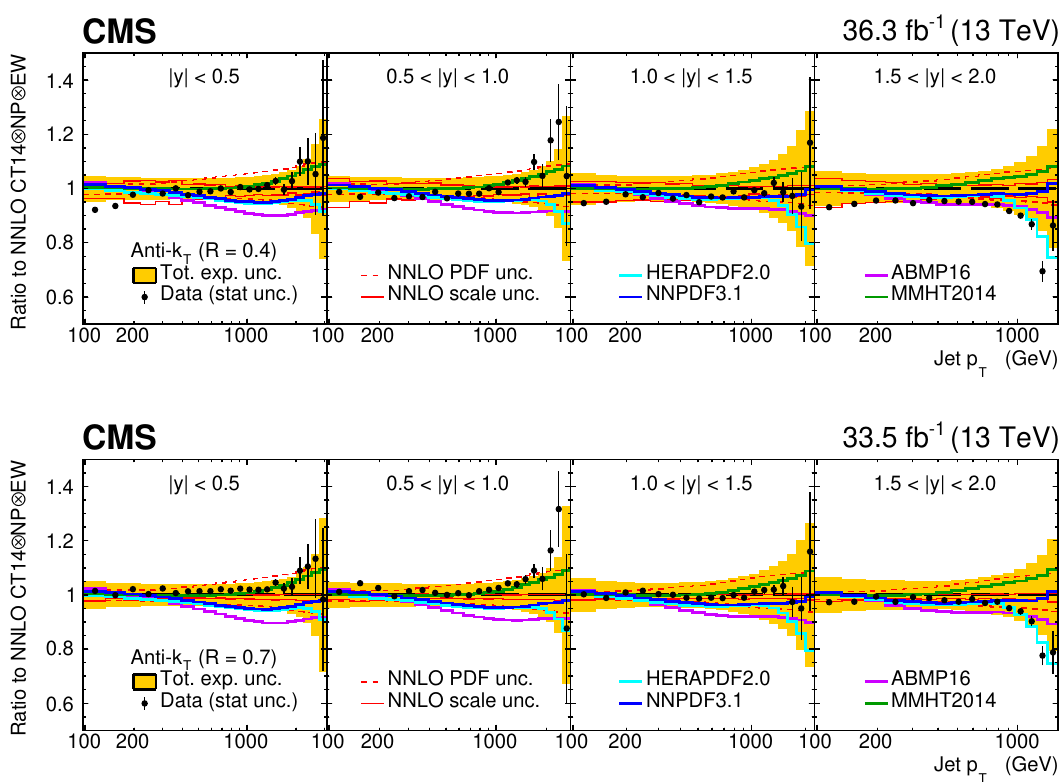
and Figure 1 . The double-differential cross section of inclusive jet production, as a function of p T algorithm with R = 0 . 4 (upper panel) and R = 0 . 7 (lower | y | , for jets clustered using the anti- k T panel), presented as ratios to the QCD predictions. The data points are shown by filled circles, with statistical uncertainties shown by vertical error bars, while the total experimental uncertainty is centred at one and is presented by the orange band. The data are divided by the NNLO prediction corrected for NP and EW effects, using CT14nnlo PDF and choosing jet p as renormalisation and T factorisation scale. NNLO predictions obtained with alternative PDF sets are displayed in different colours as a ratio to the central prediction using